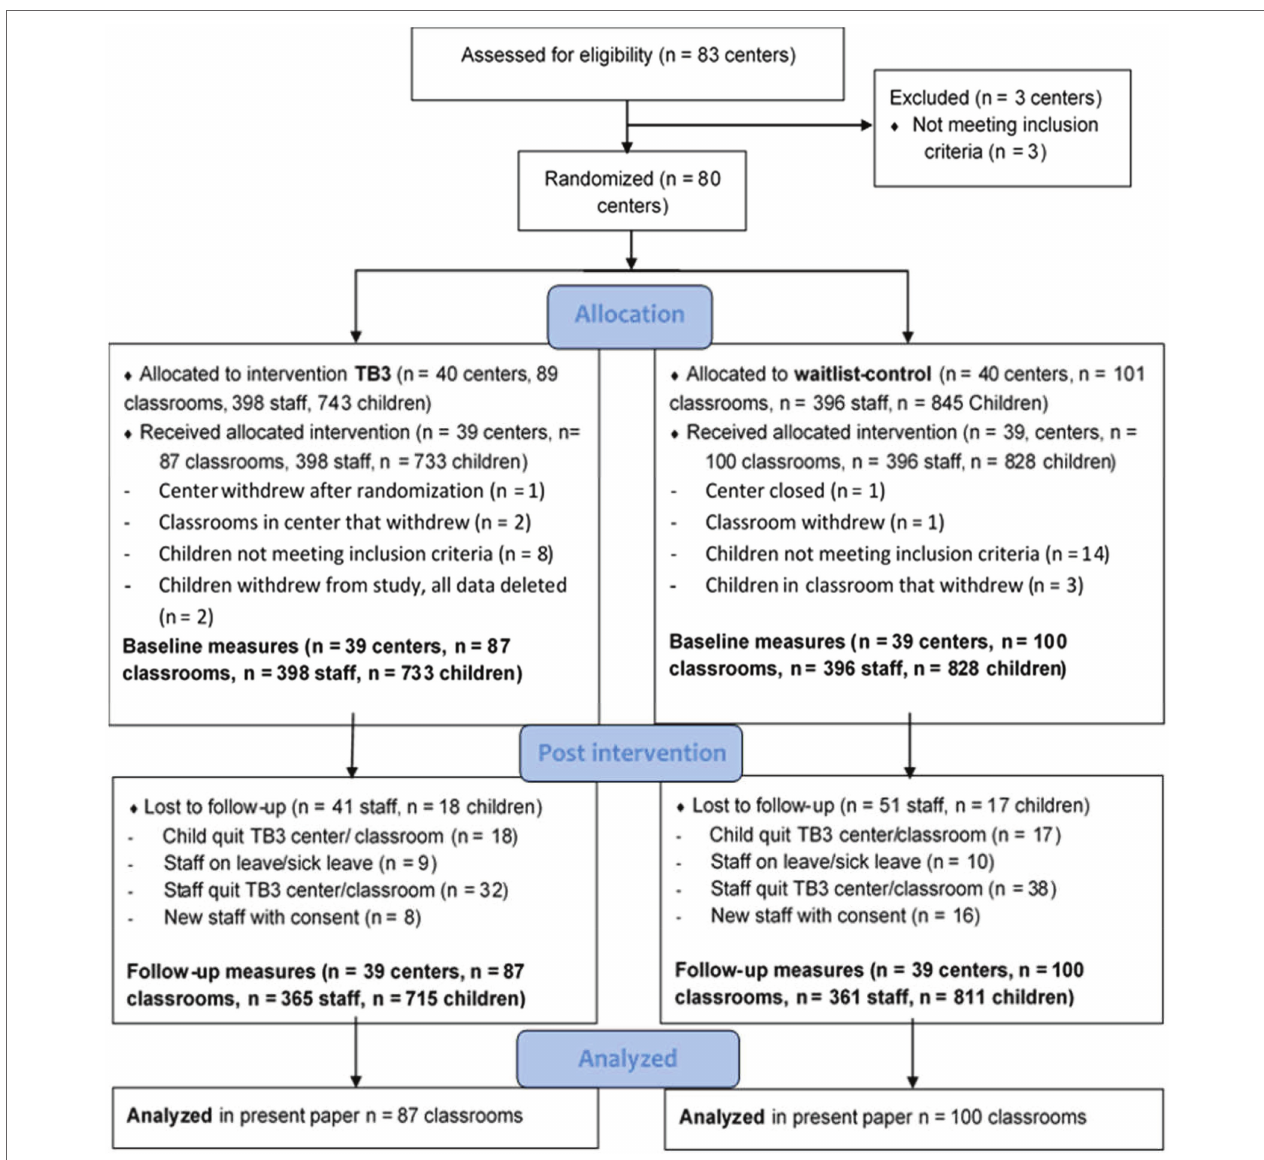
FIGURE 1 | CONSORT flow diagram of recruitment, randomization, and participation of childcare centers, classrooms, staff (including leaders), and children in the Thrive by Three (TB3)